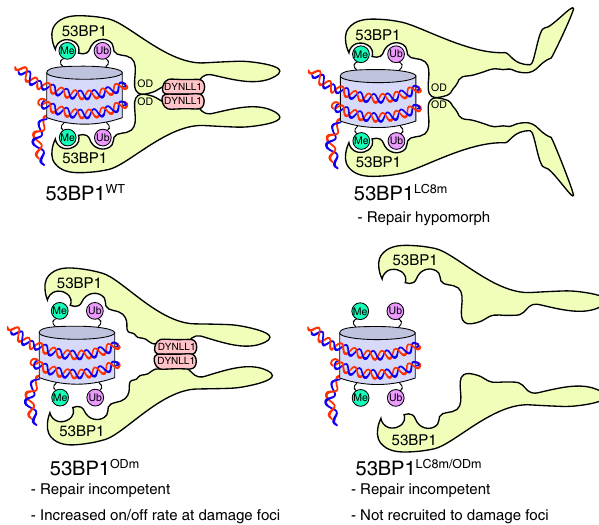
Fig. 6 DYNLL1 and the OD mediate a bivalent mode of 53BP1 oligomerization. 53BP1 localisation and function is dependent upon bivalent OD- and DYNLL1-mediated modes of oligomerization (top, left). OD- mediated oligomerization alone is suf fi cient for chromatin binding but results in severe DSB repair defects (top, right). DYNLL1-mediated oligomerization is also suf fi cient to support recruitment of 53BP1 to damage sites, but does not support DNA repair (bottom, left). Loss of both OD and DYNLL1-mediated modes of oligomerization eliminates 53BP1 recruitment to DNA damage sites and all associated repair functions (bottom,